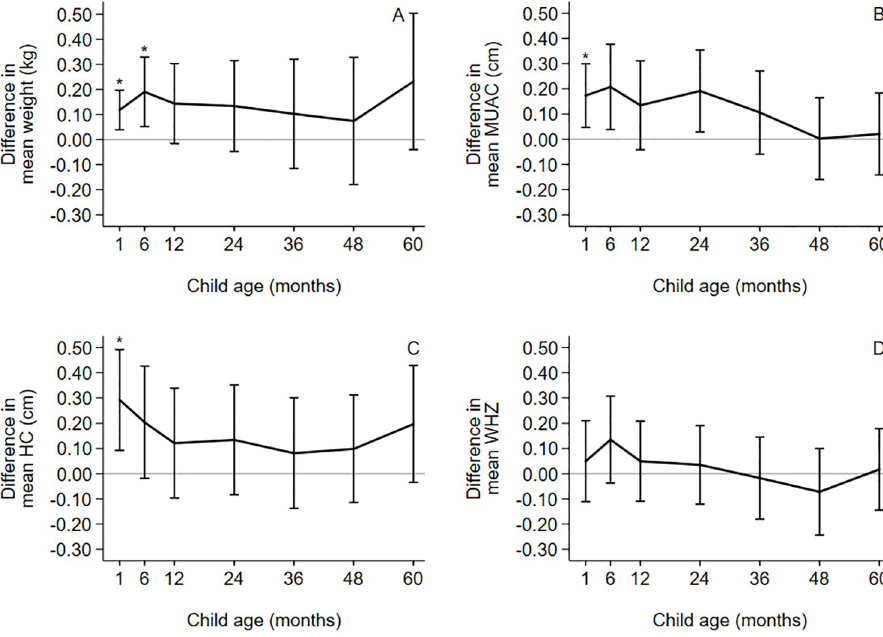
Fig 3. Differences between groups and 95% confidence interval for AZI-SP vs control in growth outcomes. (A) Mean weight (kg). (B) Mean mid-upper arm circumference (cm). (C) Mean head circumference (cm). (D) Mean weight-for-height Z-score (WHZ). SP = sulfadoxine-pyrimethamine; AZI-SP = intervention group with monthly SP and two doses of azithromycin. � denotes global P <